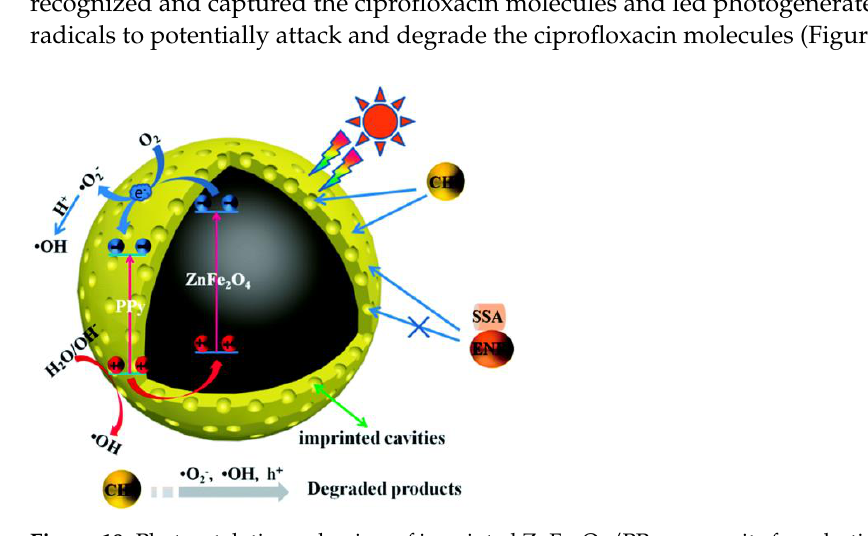
Figure 18. Photocatalytic mechanism of imprinted ZnFe 2 O 4 /PPy composite for selective degradation of ciprofloxacin [142].